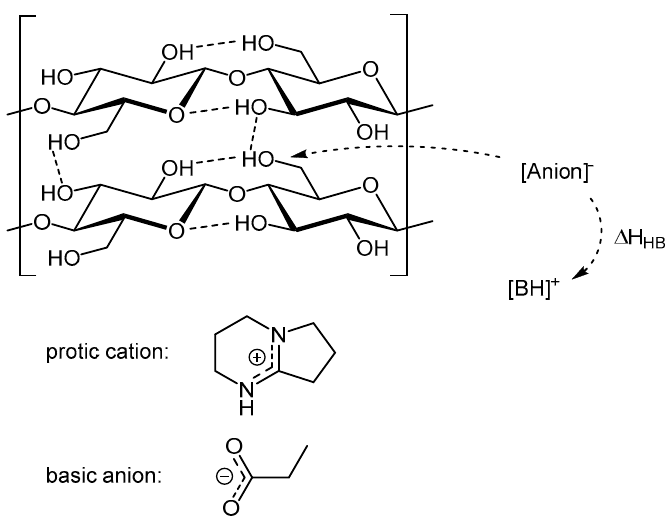
Figure 7. Model for the dissolution of cellulose in protic QAEs on the basis of super bases; redrawn from